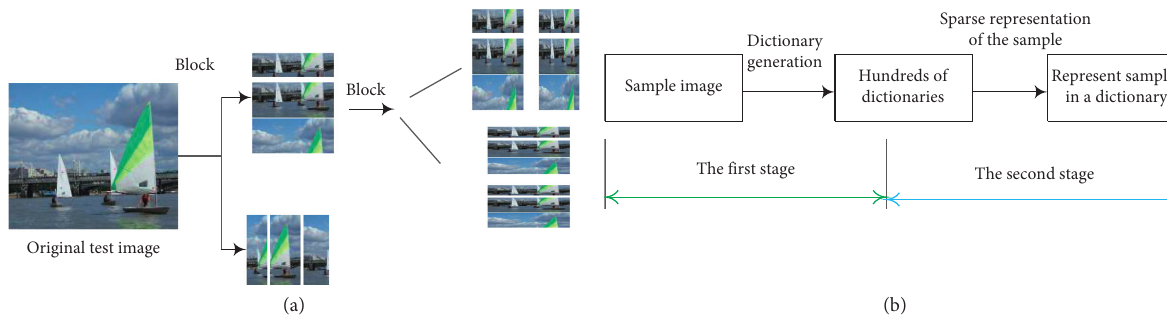
Figure 3: Dictionary training